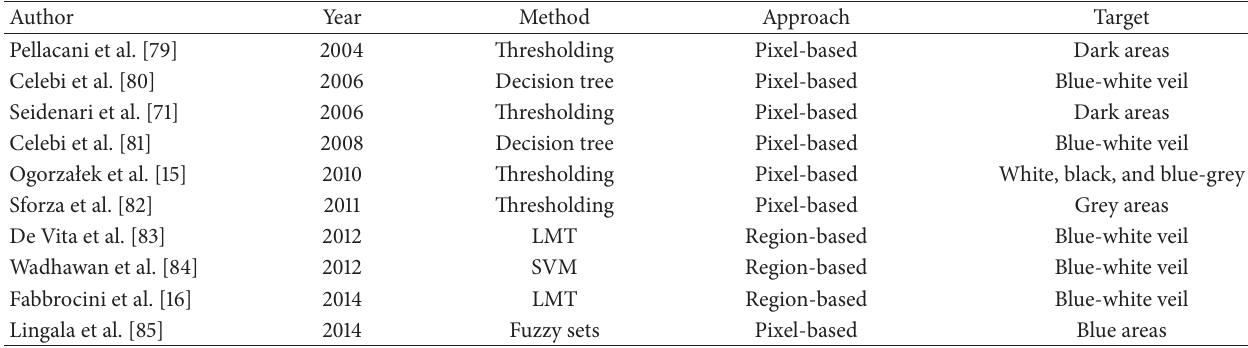
Table 4: Colour detection